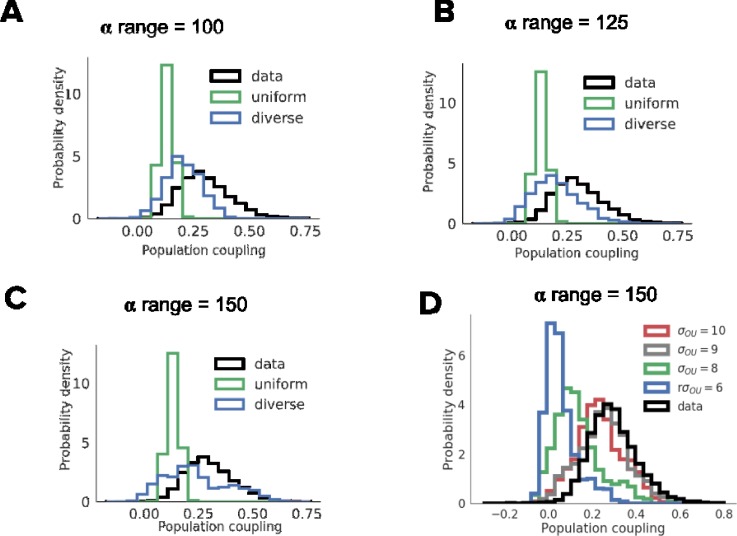
Dependence of the distribution of population coupling on the range of learning rate (A-C) and the amplitude of injected noise (D).